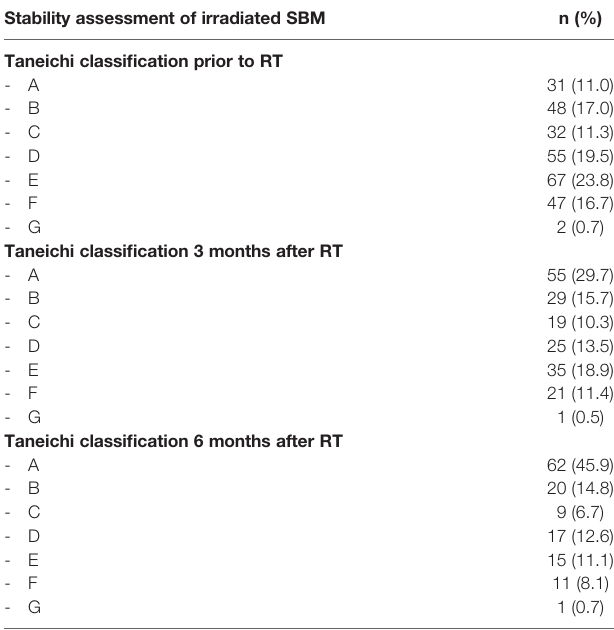
TABLE 4 | Stability assessment of irradiated SBM before and after palliative RT according to the Taneichi score. Stability assessment of irradiated SBM n (%) Taneichi classi fi cation prior to RT - A